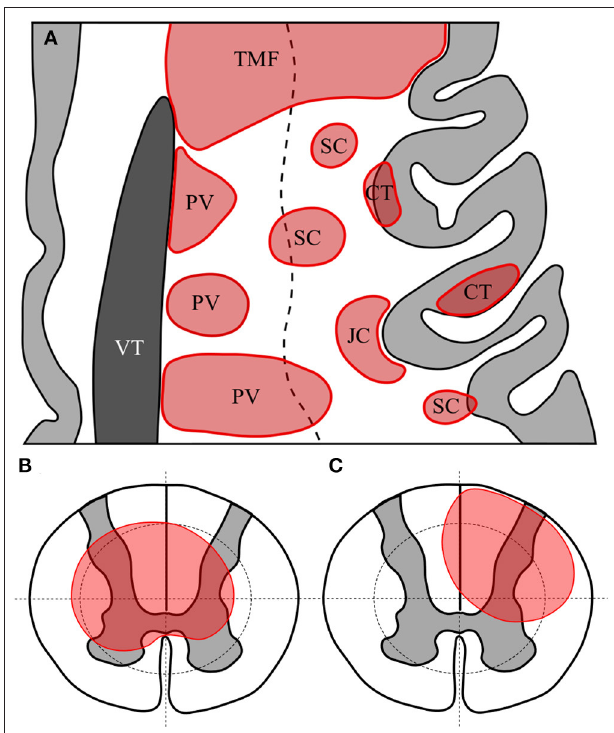
FIGURE 1 | Representative axial section of left frontal cortex with cortex in light grey and lateral ventricle in dark grey (A) . White matter lesions are shown in red. TMF, tumefactive lesion—note size > 3cm and extension from ventricular surface to juxtacortical zone; PV, periventricular—note lesions abutting or immediately adjacent to lateral ventricle; CT, cortical—lesion wholly or predominantly located with the cortex; JC, juxtacortical—subcortical white matter lesion following the contour of the cortex but sparing the U-fibre layer; SC, subcortical—any other lesion predominantly located superficial to an imaginary line drawn half-way between the lateral ventricular surface and the cortex. Diagrammatic representation of axial section of spinal cord showing quadrantic segmentation of central and peripheral zones used to define lesions, showing (B) a central spinal cord lesion occupying at least a part of all central quadrants and (C) a partial spinal cord lesion occupying part of only three central